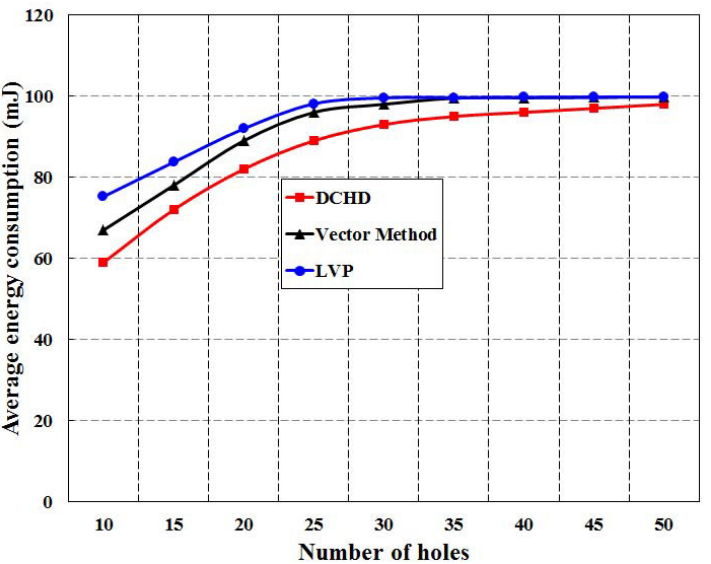
Figure 13. Comparison of DCHD with other protocols in terms of the average energy